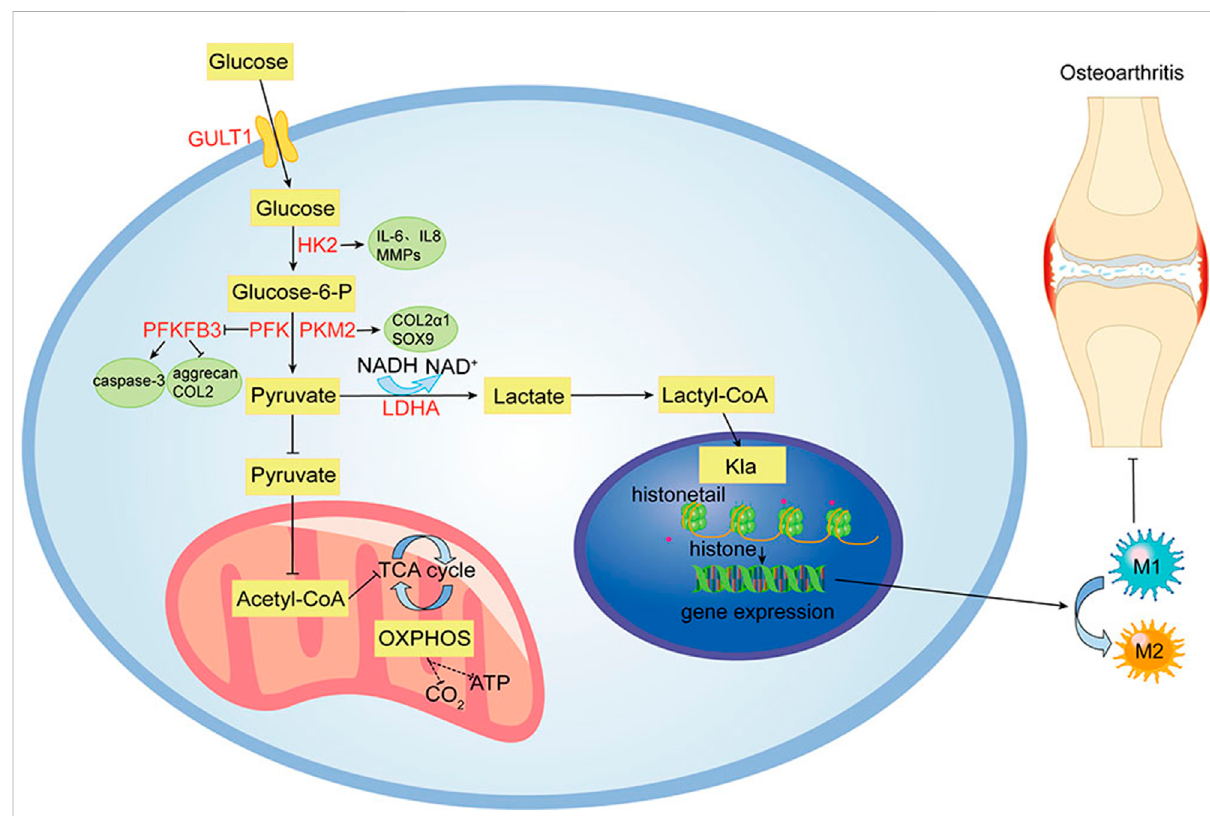
FIGURE 1 GlycolyticmetabolismpathwaysofOA.Underhypoxicandin fl ammatoryconditionsinOAjoints,cellularglycolysisisenhancedforrapidenergy production.Manyenzymesinvolvedinglycolysis,includingHK2,PKM2,PFKFB3,andLDHA,areabnormallyexpressedinOAchondrocytes.Lactate,a metabolite of glycolysis, reduces M1 macrophage activation and promotes M2 macrophage polarization by modifying histones.